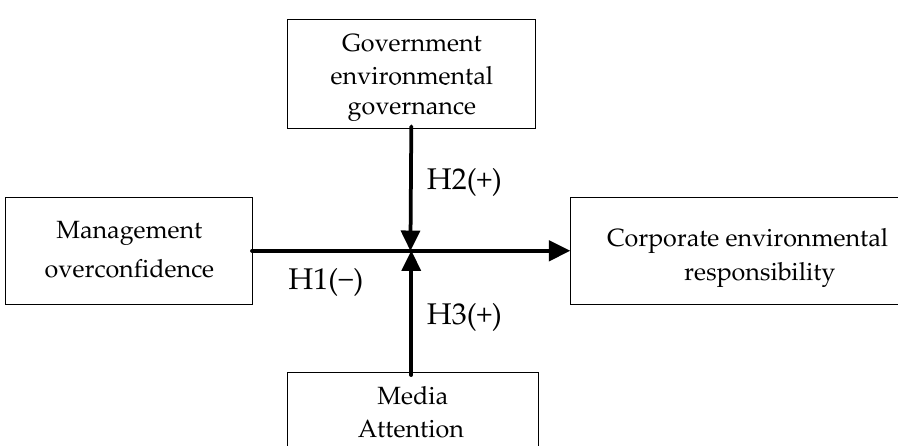
Figure 1. A research framework (developed by authors).